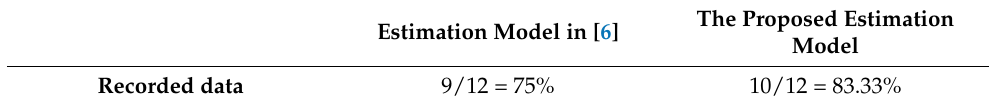
Table 6. SOC estimation for the trip